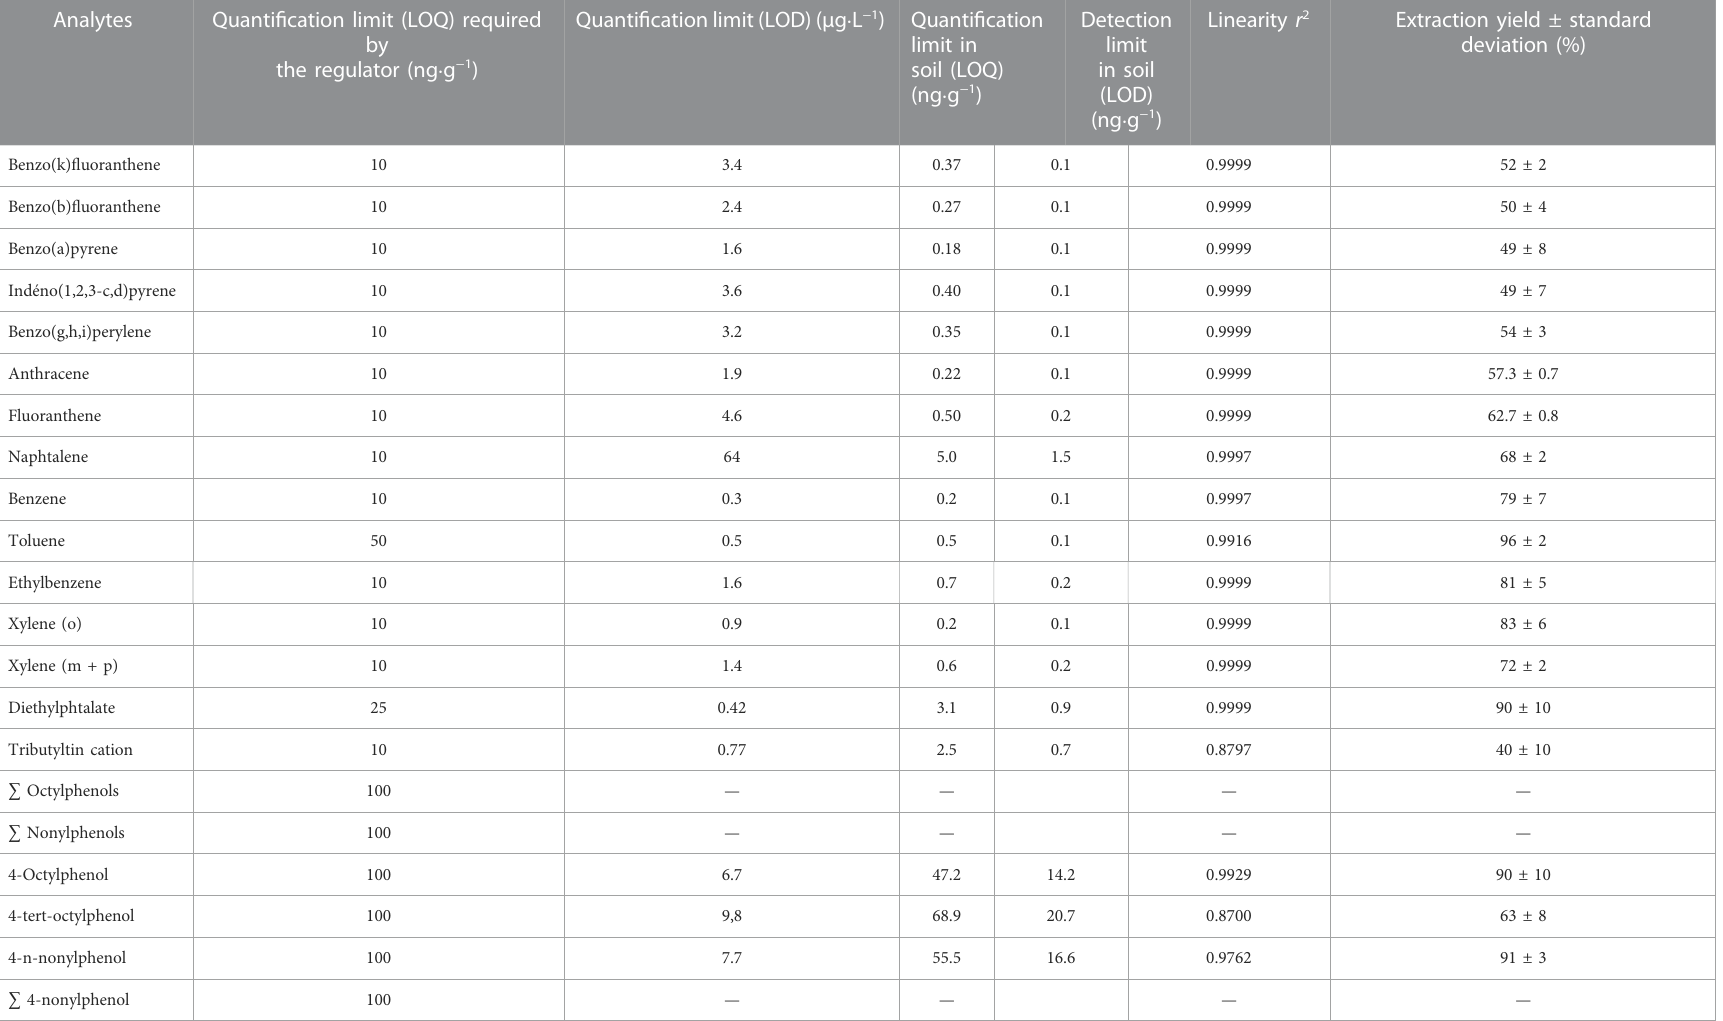
TABLE 1 Quanti fi cation limits, detection limit, linearity and extraction yield of the